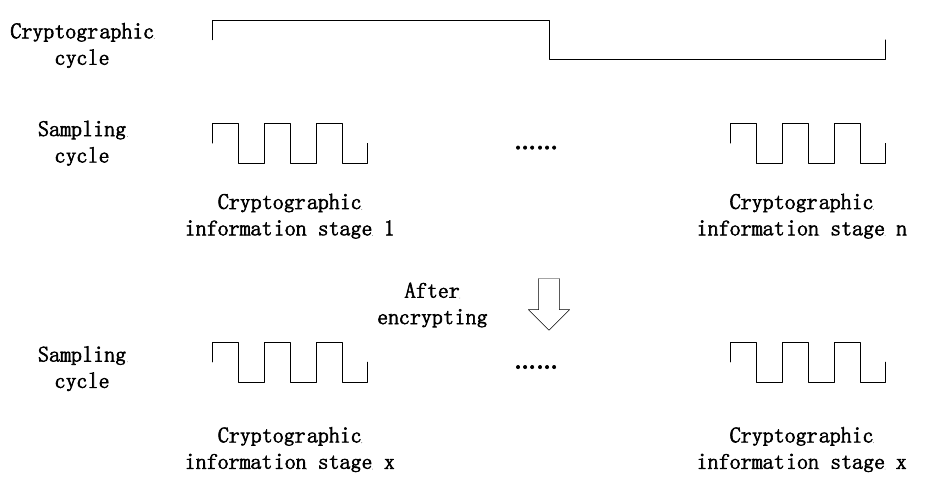
Figure 5. Disrupting the order of encrypted information segments.